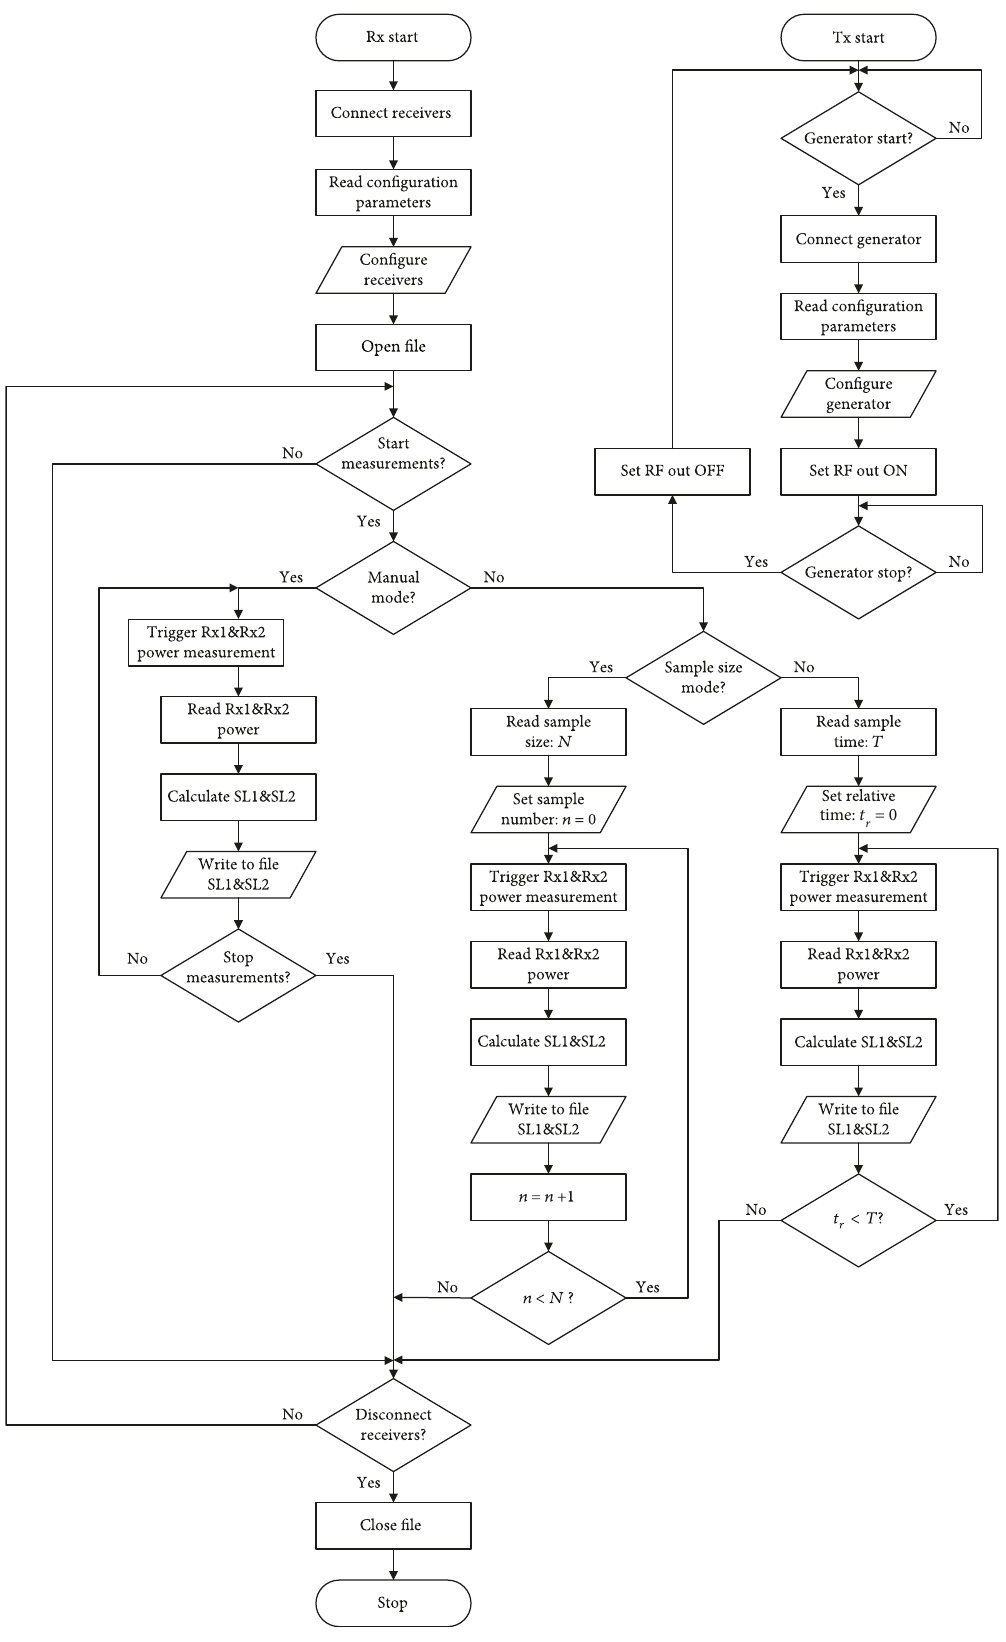
Figure 2: Simpli fi ed algorithm of control software for performing system loss